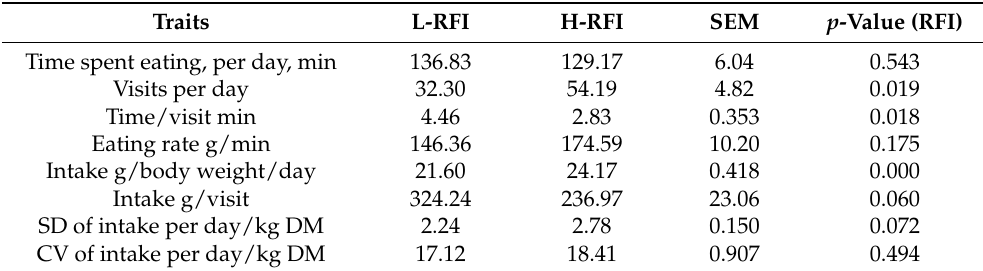
Table 4. Feeding behavior of animals with low and high RFI. RFI: residual feed intake; SD: standard deviation; CV: coefficient of variation; DM: dry